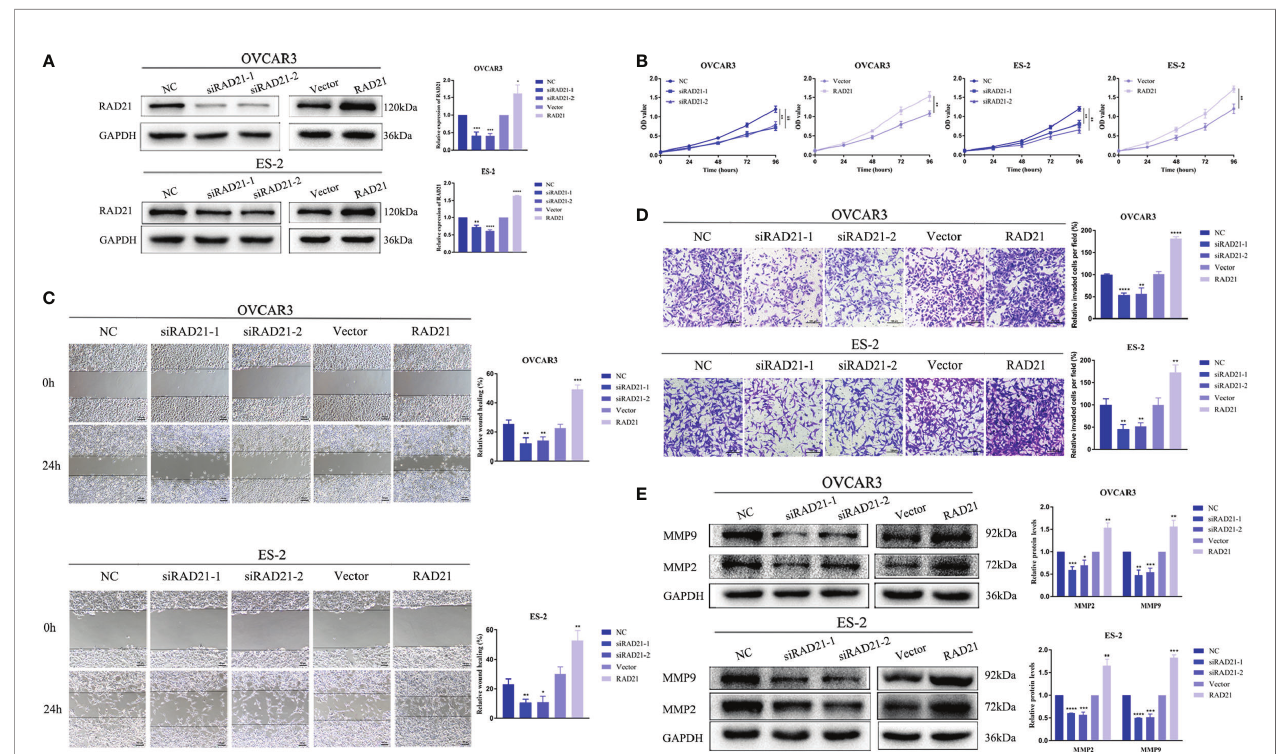
FIGURE 2 | RAD21 overexpression promoted proliferation, migration, and invasion of ovarian cancer cells. (A) RAD21 expression after transfection with siRNA or lentivirus. (B) Ovarian cancer cell post-transfection proliferation ability evaluated using Cell Counting Kit-8 (CCK8) assays. (C) Ovarian cancer cell post-transfection migration ability evaluated using wound-healing assays. (D) Ovarian cancer cell post-transfection invasion ability evaluated using invasion assays. (E) The expression of matrix metalloproteinase 2 (MMP2) and MMP9 after transfection measured using Western blotting. Data were represented as mean ± SD (n = 3). * p < 0.05; ** p < 0.01; *** p < 0.001; **** p <